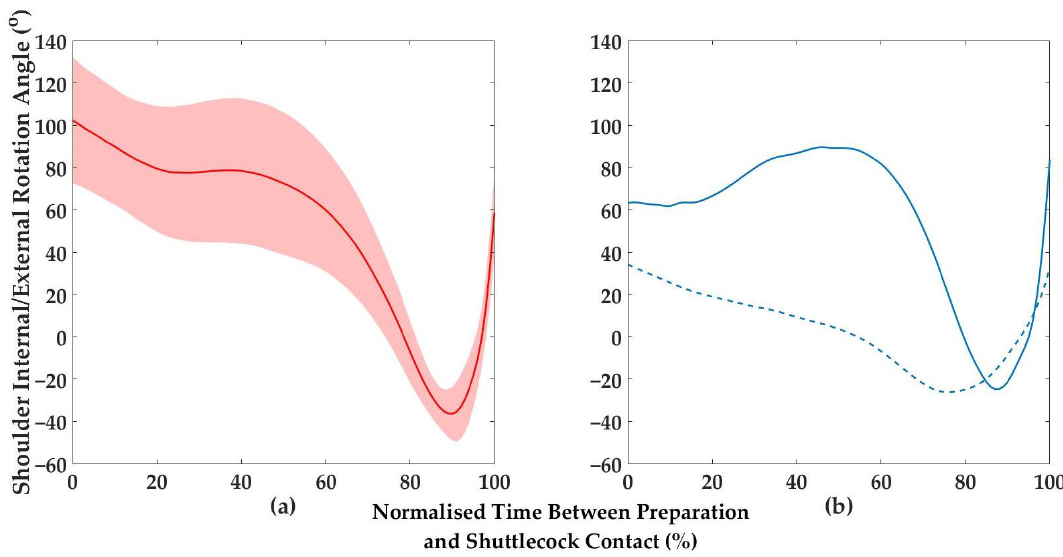
Figure 3. ( a ) Mean (solid line) ± SD (shaded area) for the normalised racket arm shoulder internal/external rotation angle between preparation and shuttlecock contact key instants. ( b ) Normalised racket arm shoulder internal/external rotation angle between preparation and shuttlecock contact key instants, for participants with the fastest (solid line) and slowest (dashed line) participant’s smash. Internal rotation (positive); external rotation (negative). A significant correlation between shuttlecock speed and shoulder internal rotation angle was present at shuttlecock contact.